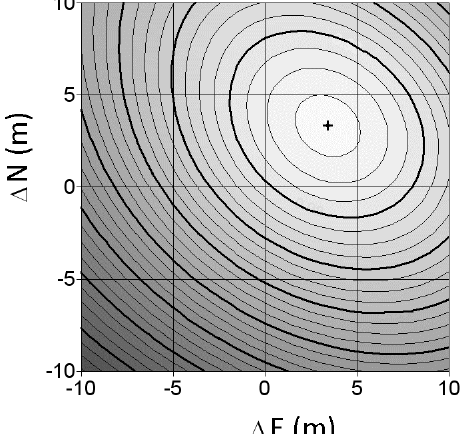
Figure 4. Graphical representation of function F, with contours. The iterative process